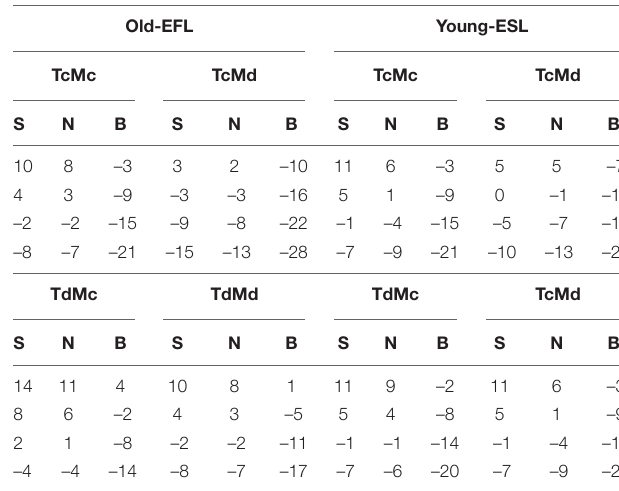
TABLE 1 | The values of the four Signal to Noise Ratios (SNRs) used under each condition: (1) compact targets and maskers (T C M C ), 2) compact targets